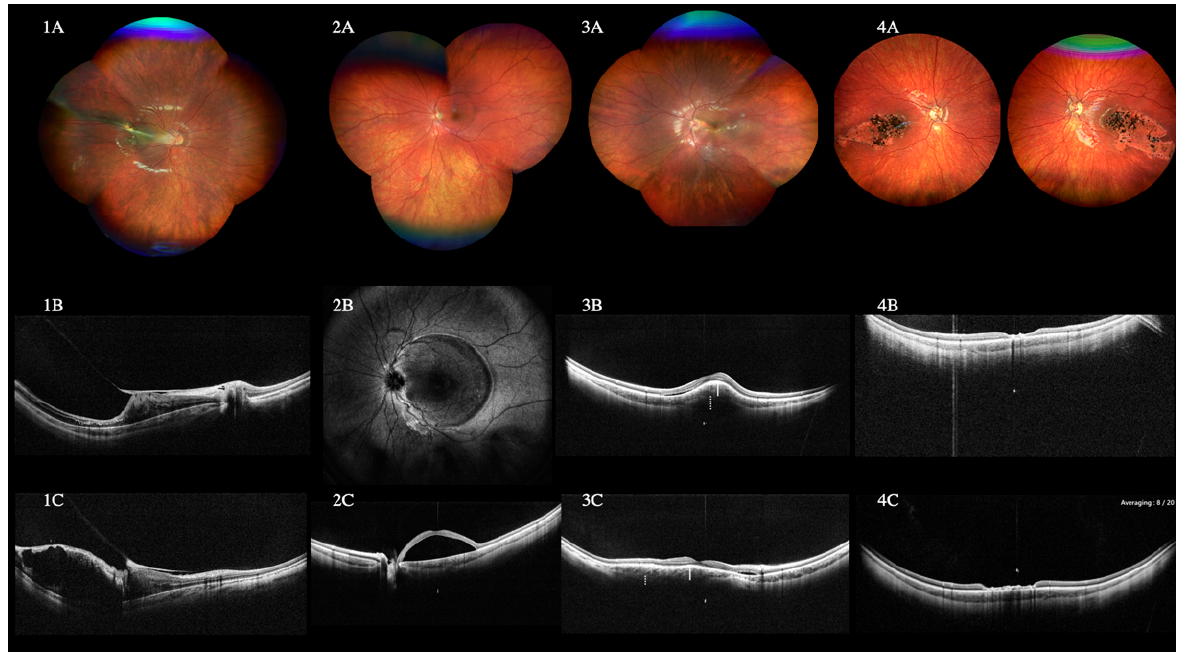
Figure 7. A case of familial exudative vitreoretinopathy (FEVR) in a 4-year-old boy is shown in the wide-field (WF) fundus color image ( 1A ), showing temporal vessels rectification, macula and papilla displacement, and a macular fold. Wide-field optical coherence tomography (OCT) shows the retinal tractions and folds ( 1B , 1C ). WF fundus color image ( 2A ), scanner laser ophthalmoscopy (SLO) image ( 2B ), and WF-OCT ( 2C ) of a 10-year-old girl with a large macular detachment secondary to an optic pit. The perimeter of the retinal detachment is delimitated on the SLO image ( 2B ). In one scan, we can appreciate the entire macular detachment, the depth of the pit, and the vitreous strand in the pit ( 2C )—a 9-year-old girl affected by tuberous sclerosis presented with a choroidal lesion. The WF color fundus image ( 3A ) shows irregular elevations at the posterior pole. The WF-OCT ( 3B , 3C ) showed a minimal extrafoveal serous detachment of the superior macula, a thickened choroid (white line), and new lesions with irregular shape under the choroid (white dotted line). A diagnosis of subchoroidal granuloma compatible with neurofibromatosis was made. A 4-year-old boy was diagnosed with retinopathy of prematurity (ROP), showing a bilateral macular irregular, an atrophic area with multiple pigmented dots in the fundus color image ( 4A , right and left eye). The WF-OCT of the right ( 4B ) and the left eye ( 4C ) confirmed the atrophy of all the macular layers with the normal choroid.